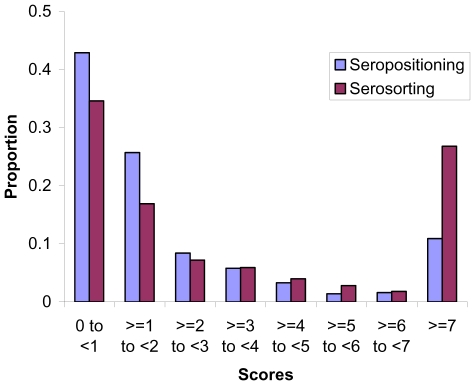
Distribution of seropositioning and serosorting scores.